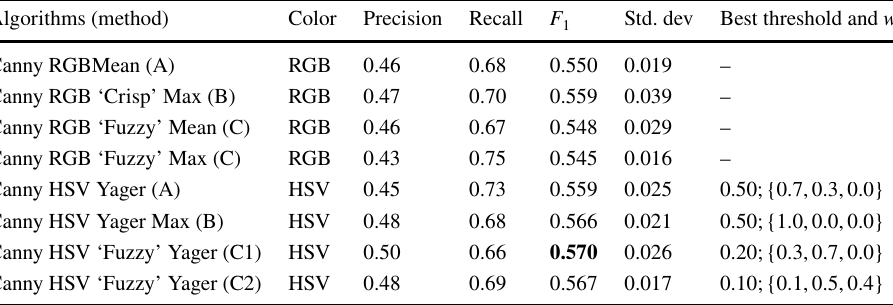
Table 3 Canny evaluated measures for HSV and RGB algorithms (average of 10 cross- validation sets)—closest human